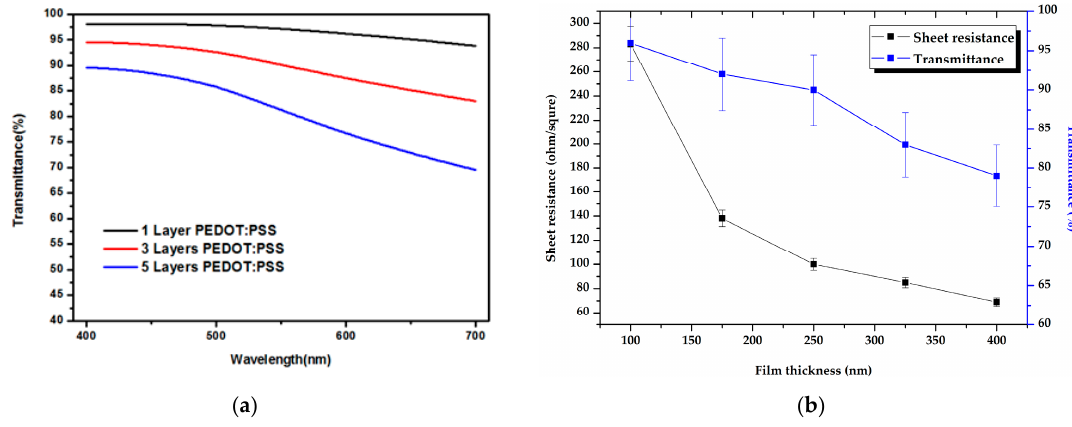
Figure 3. ( a ) Transmittance of one, three, and five layers of PEDOT:PSS films; ( b ) Variation of R sq and the transmittance of average value in the visible wavelength with film thickness for PEDOT:PSS.